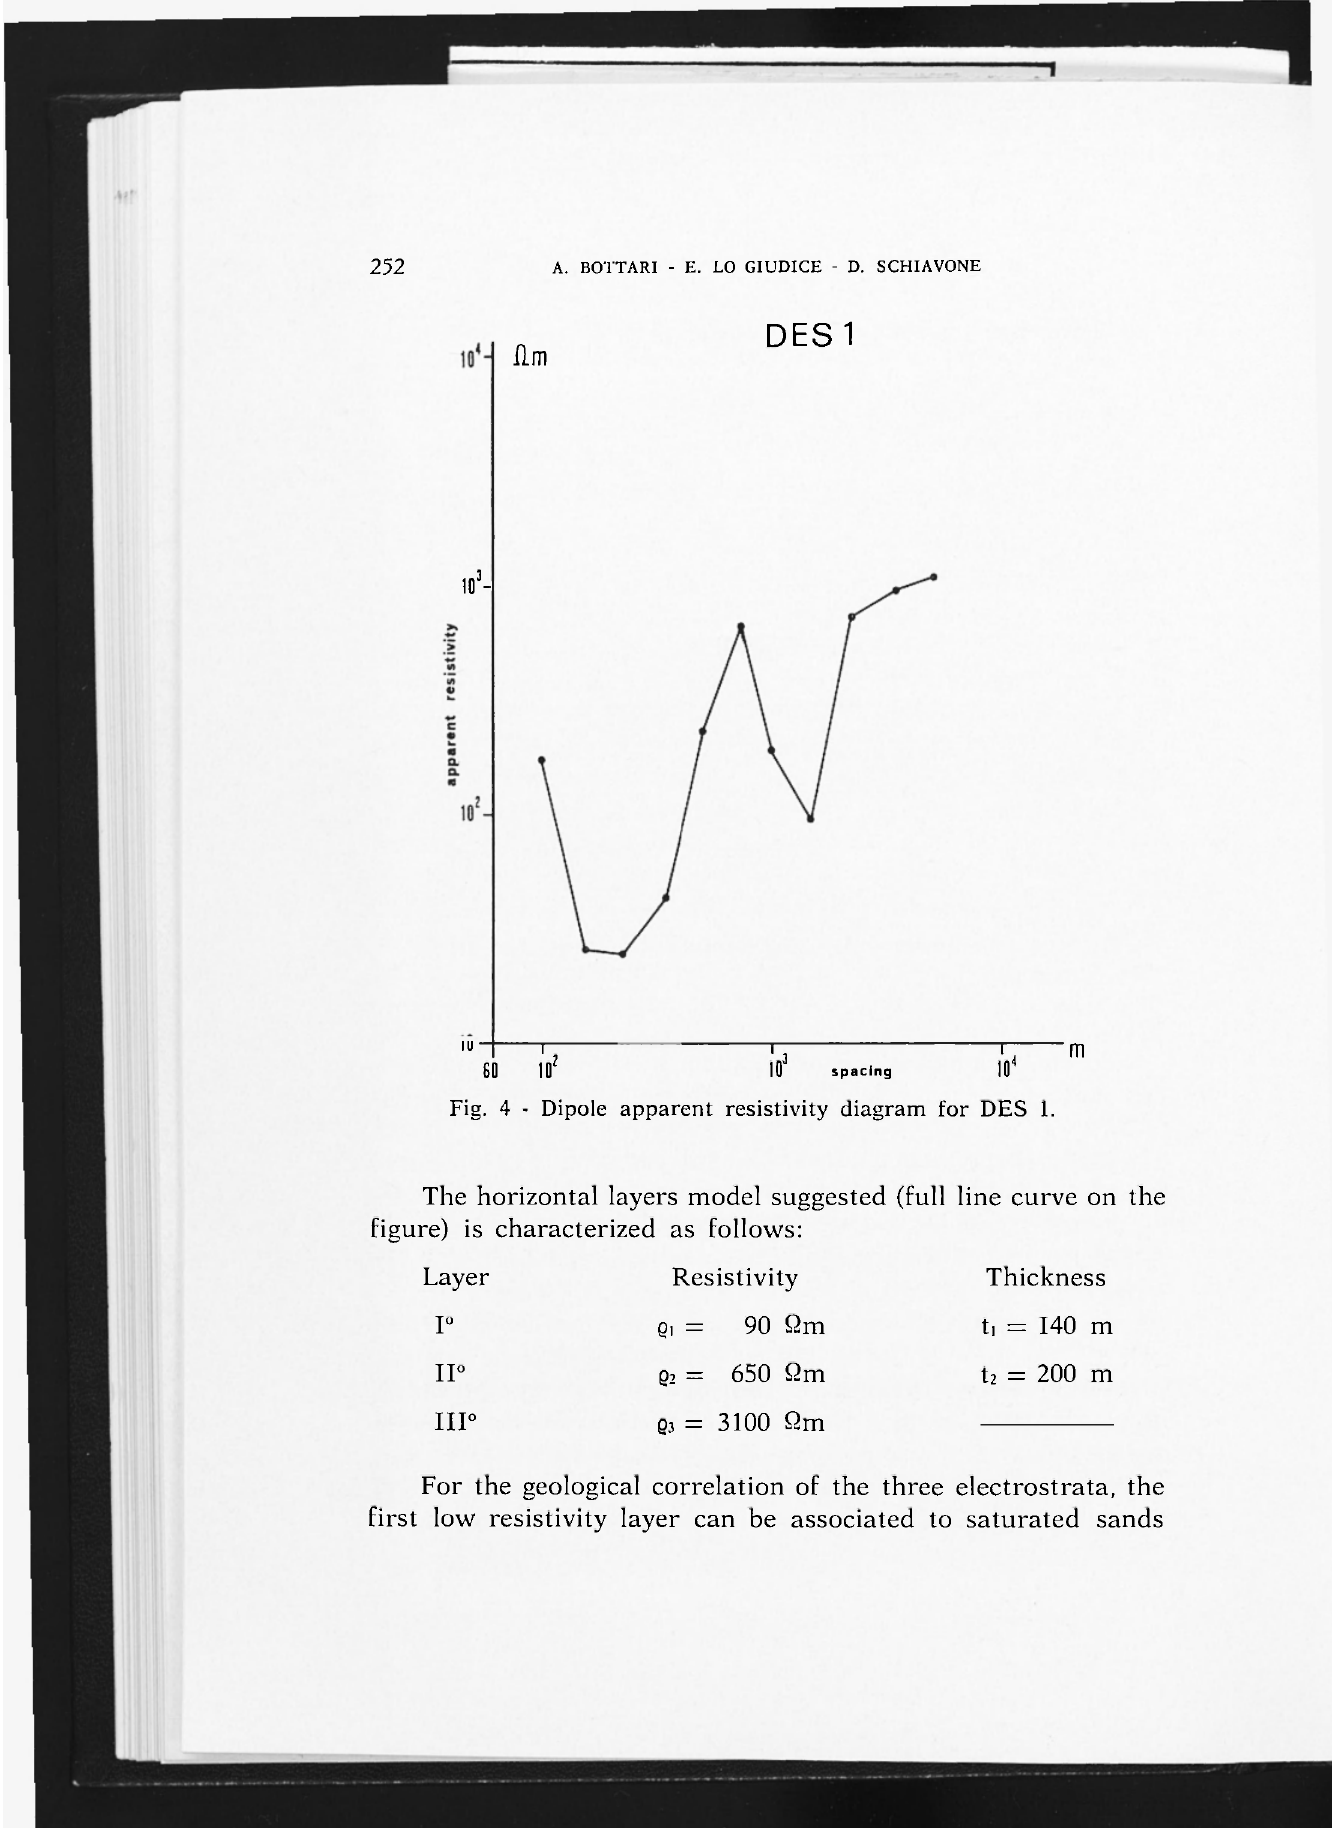
For the geological correlation of the three electrostrata, the first low resistivity layer can be associated to saturated